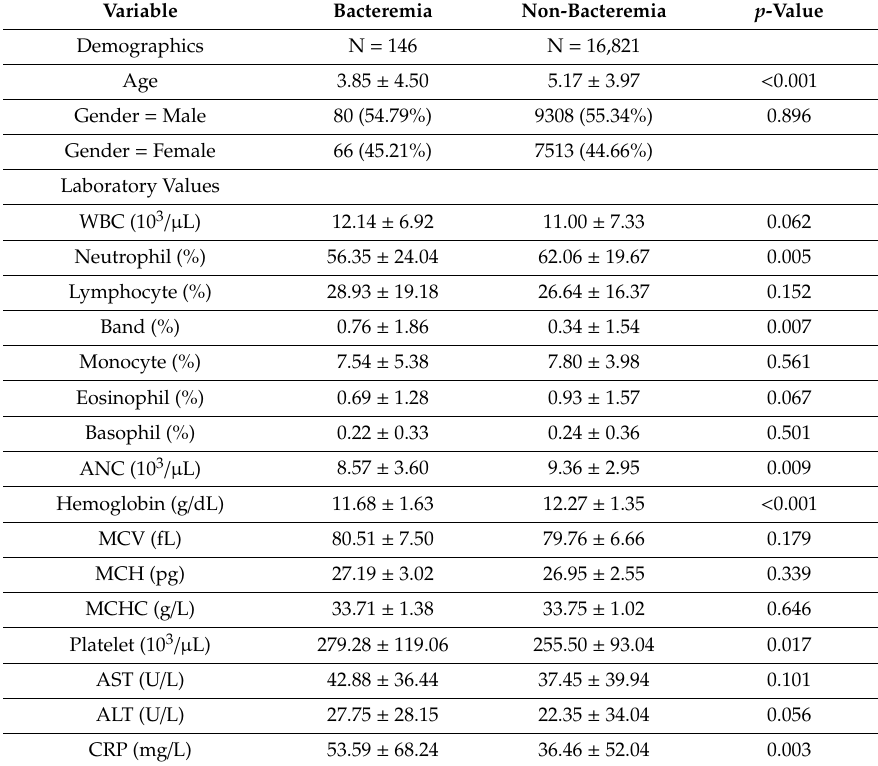
Table 1. Distribution of several variables in febrile children with or without bacteremia.